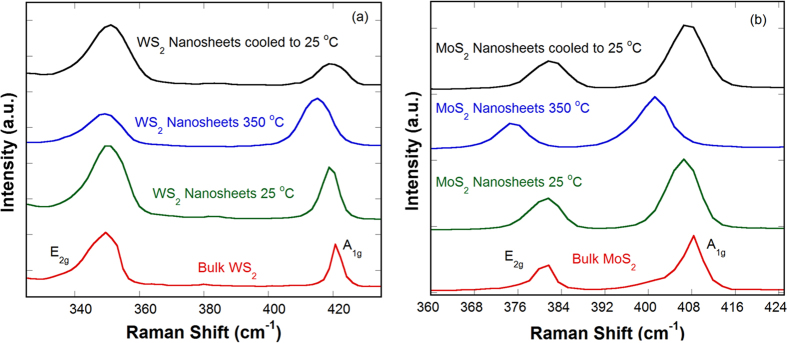
Characterization by Raman spectroscopy.Raman spectra for (a) WS2 and (b) MoS2.